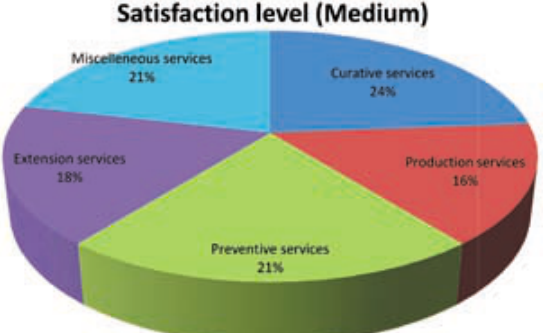
Fig.1. Distribution of livestock farmers based on their satisfaction regarding livestock services provided by the dairy